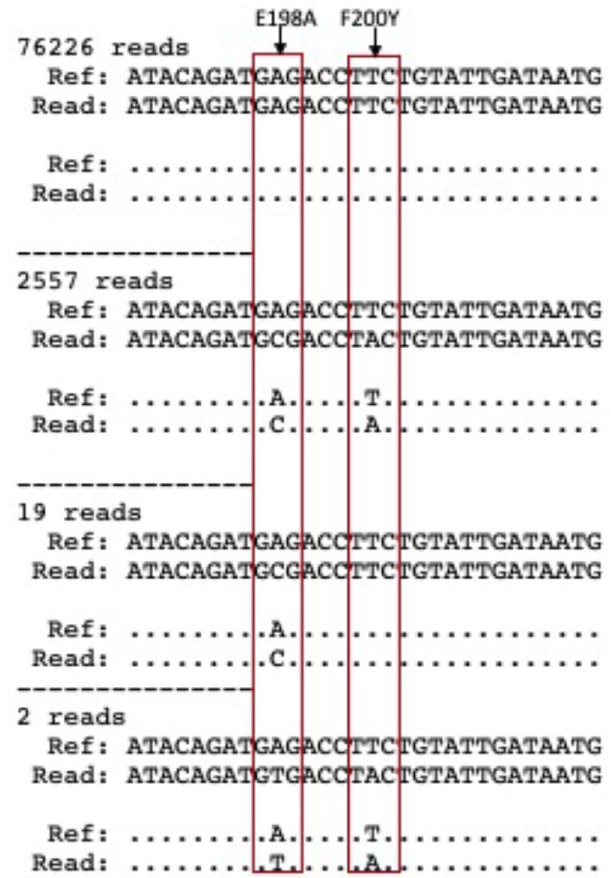
Figure 3. For study sample #5803, 3.2% of the total amplicon reads contained both E198A and F200Y resistance associated SNPs of the Necator americanus isotype-1 β -tubulin gene. Of these, 99.3% of the E198A reads also contained